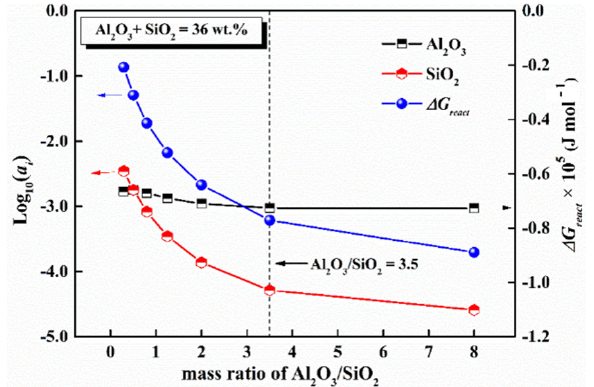
Figure 4. Effect of mass ratio of Al 2 O 3 /SiO 2 on the activities of Al 2 O 3 and SiO 2 and the reactivity of mold flux. Table 6. Composition of various flux systems for investigating the effect of components on the ac- tivities of Al 2 O 3 and SiO 2 (wt%).